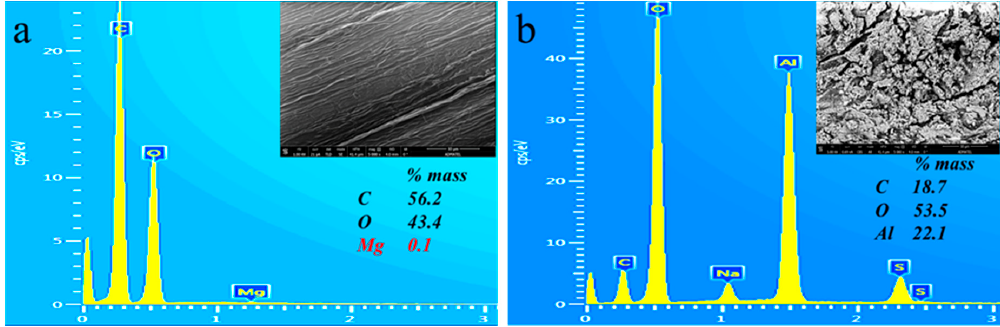
Figure 10. Sample EDS spectra of: ( a ) NaOH-treated; and ( b ) Al 2 (SO 4 ) 3 -treated abaca.